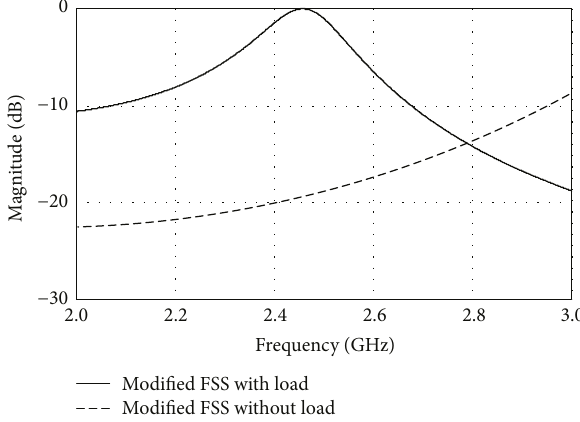
Figure 6: The simulated magnitude of the transmission coe ffi cient of the modi fi ed FSS with and without load ( d . 1